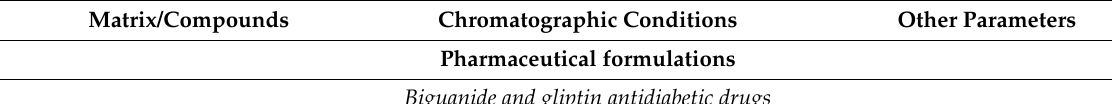
Table 2. HPLC in pharmaceutical and phytochemical